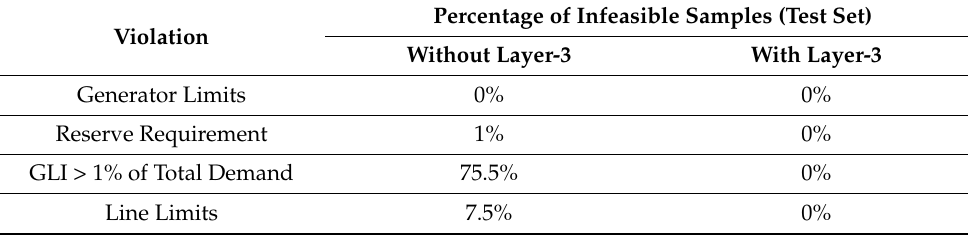
Table 5. Layer-3 Performance (4-Bus System).